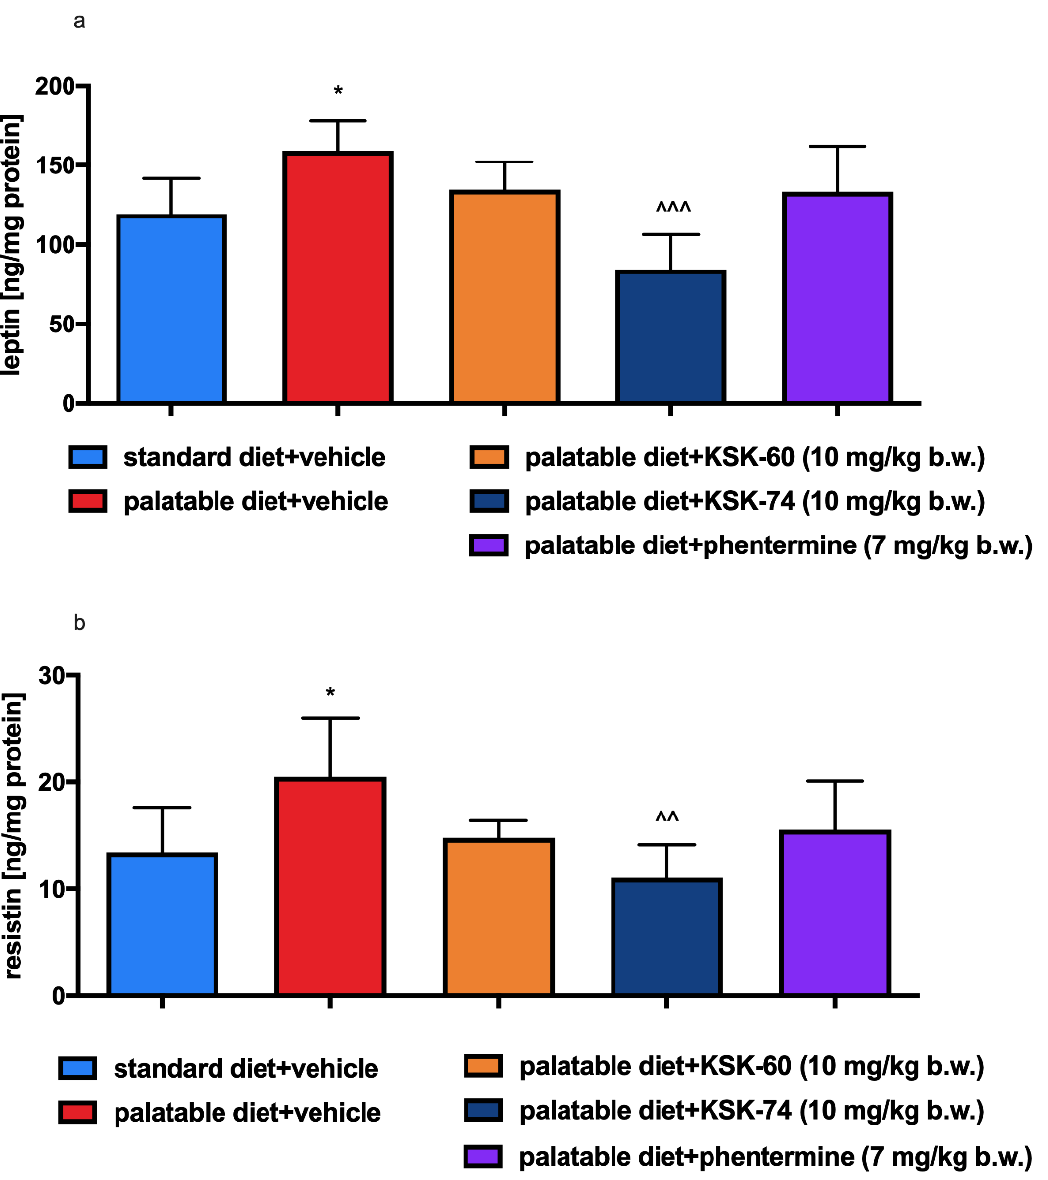
Figure 11. Effect of the tested compounds or phentermine on adipose tissue levels of ( a ) leptin and ( b ) resistin. Results are expressed as means ± SD, n = 6. Comparisons were performed by one-way ANOVA, Tukey’s post hoc test; * significant vs. standard diet + vehicle group; ^ significant vs. palatable diet + vehicle group * p < 0.05, ^^ p < 0.01, ^^^ p < 0.001.